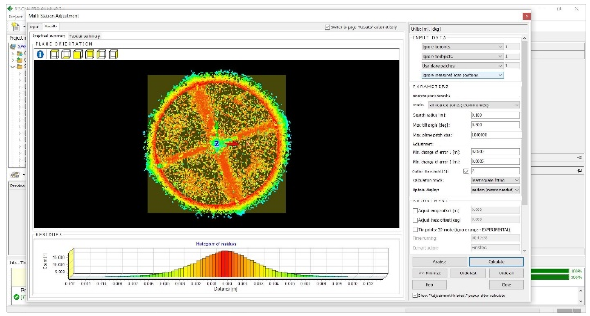
Figure 4. Check of the automated alignment of scan positions: results of the multi station adjustment process